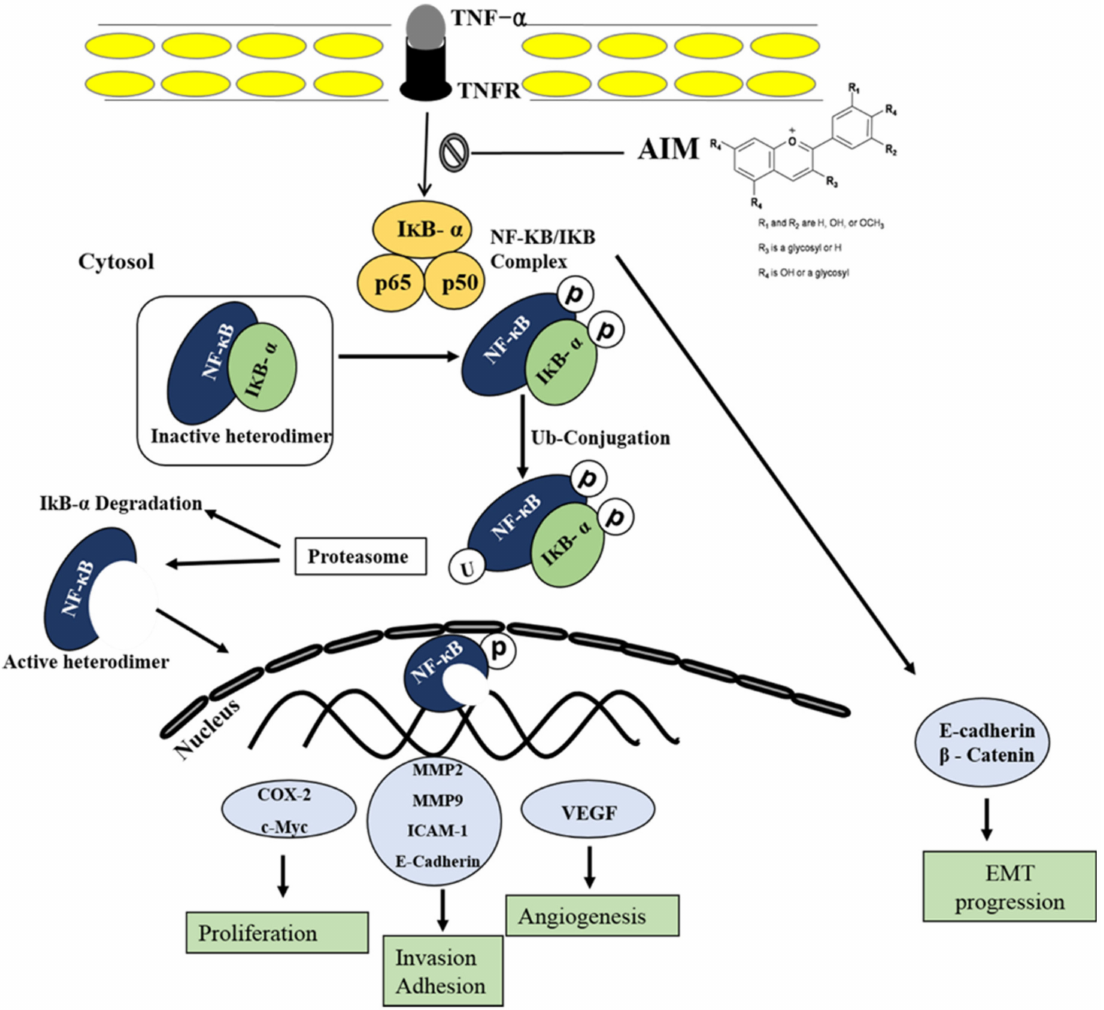
Figure 6. Schematic representation of AIM on TNF- α induced e ff ect on MCF-7 breast cancer cells. Following activation of the NF- κ B pathways, AIM inhibited TNF- α -induced NF- κ B activities and NF- κ B-regulated proteins involved in cancer cell proliferation, invasion, and angiogenesis. Taken together, these data suggest that AIM may act as a TNF- α inhibitor by suppressing NF- κ B pathways on human breast